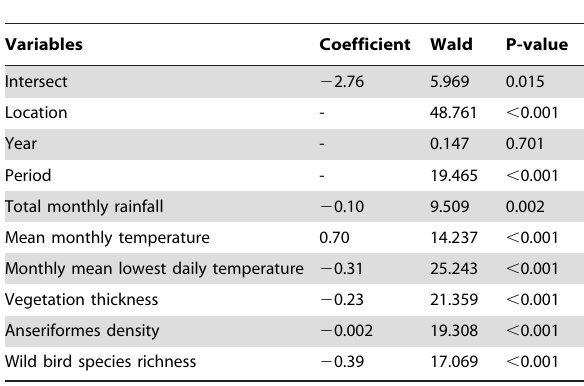
Table 5. Summary of the stepwise model selection procedure based on AICc used to model avian influenza virus prevalence.